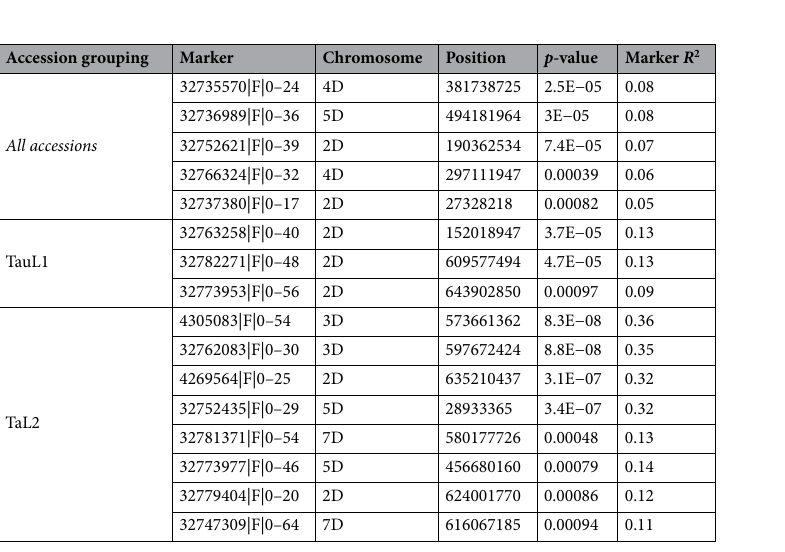
Table 2. Marker-trait associations obtained for all Aegilops tauschii accessions, as well as TauL1 and TauL2 lineages analyzed separately. GWAS used a mixed linear model with markers revealed by DArTseq.